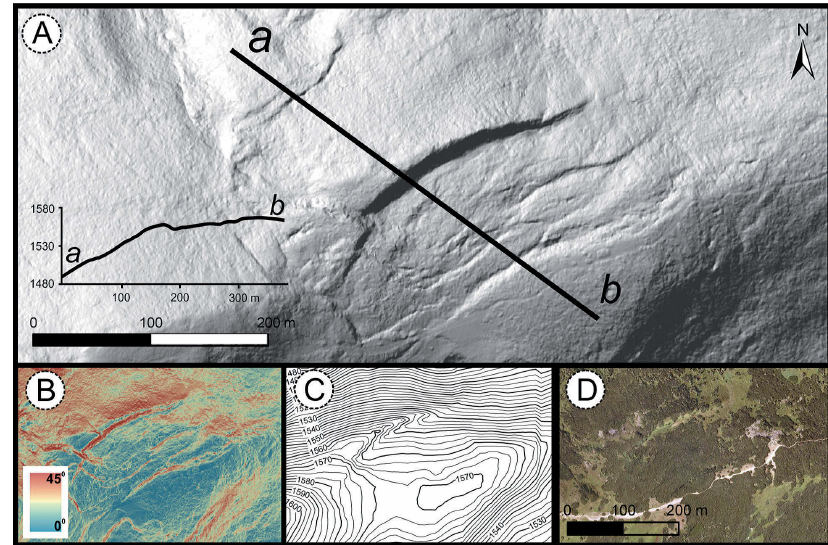
Fig. 2. Test area No 1. A – LiDAR image (a–b – topographic profile and its location), B – the map of slope reductions generat- ed from LiDAR (range of slope reductions is given), C – contour-line map, D – orthophotomap. Maps B–D at the same scale, Map A at larger scale